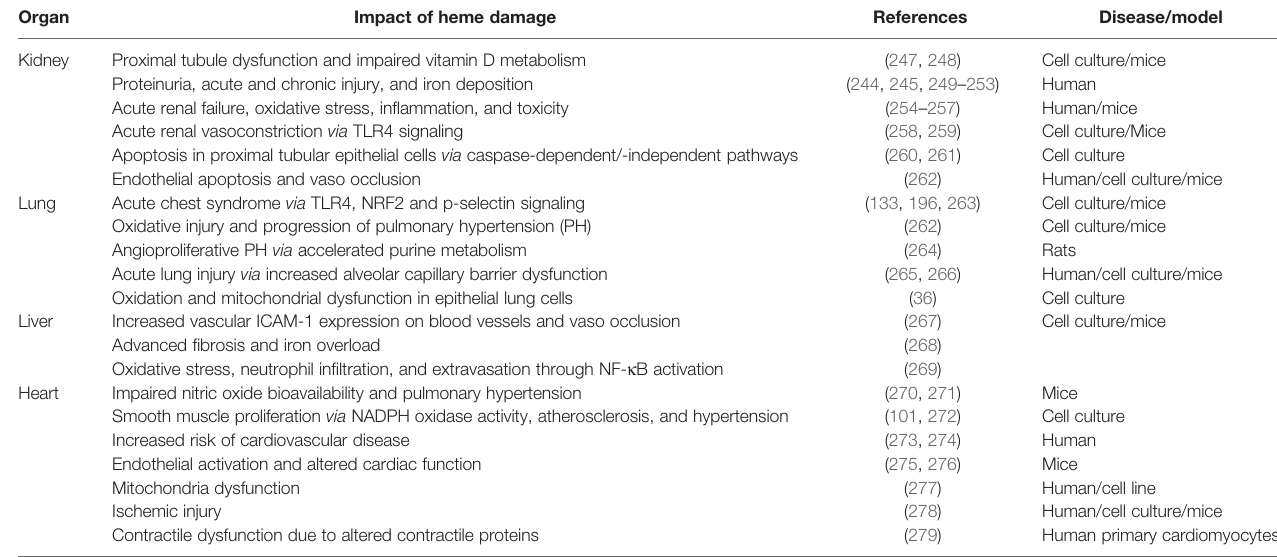
TABLE 1 | Summary of current literature supporting a damaging role of hemolysis in different